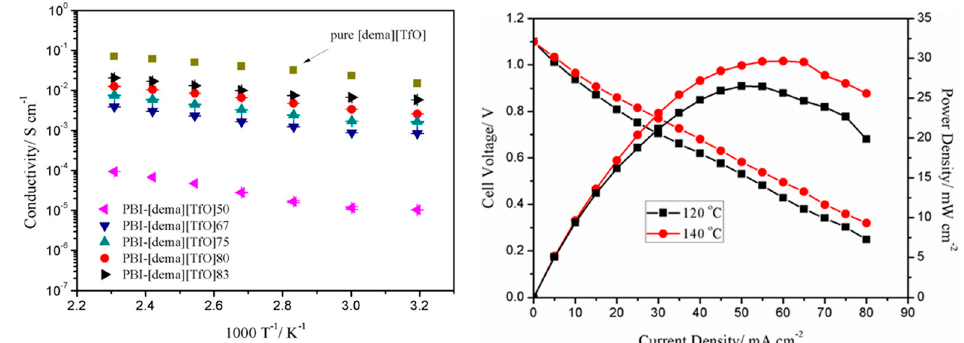
Figure 23. Variation of the conductivity of the ionic liquid (IL) and membranes at di ff erent temperatures ( left ) and polarization curve of an anhydrous H 2 / Cl 2 fuel cell using the PBI / [dema][TfO] 83 composite membrane at di ff erent temperatures ( right ). Reproduced from [229] with permission of the American Chemical Society.